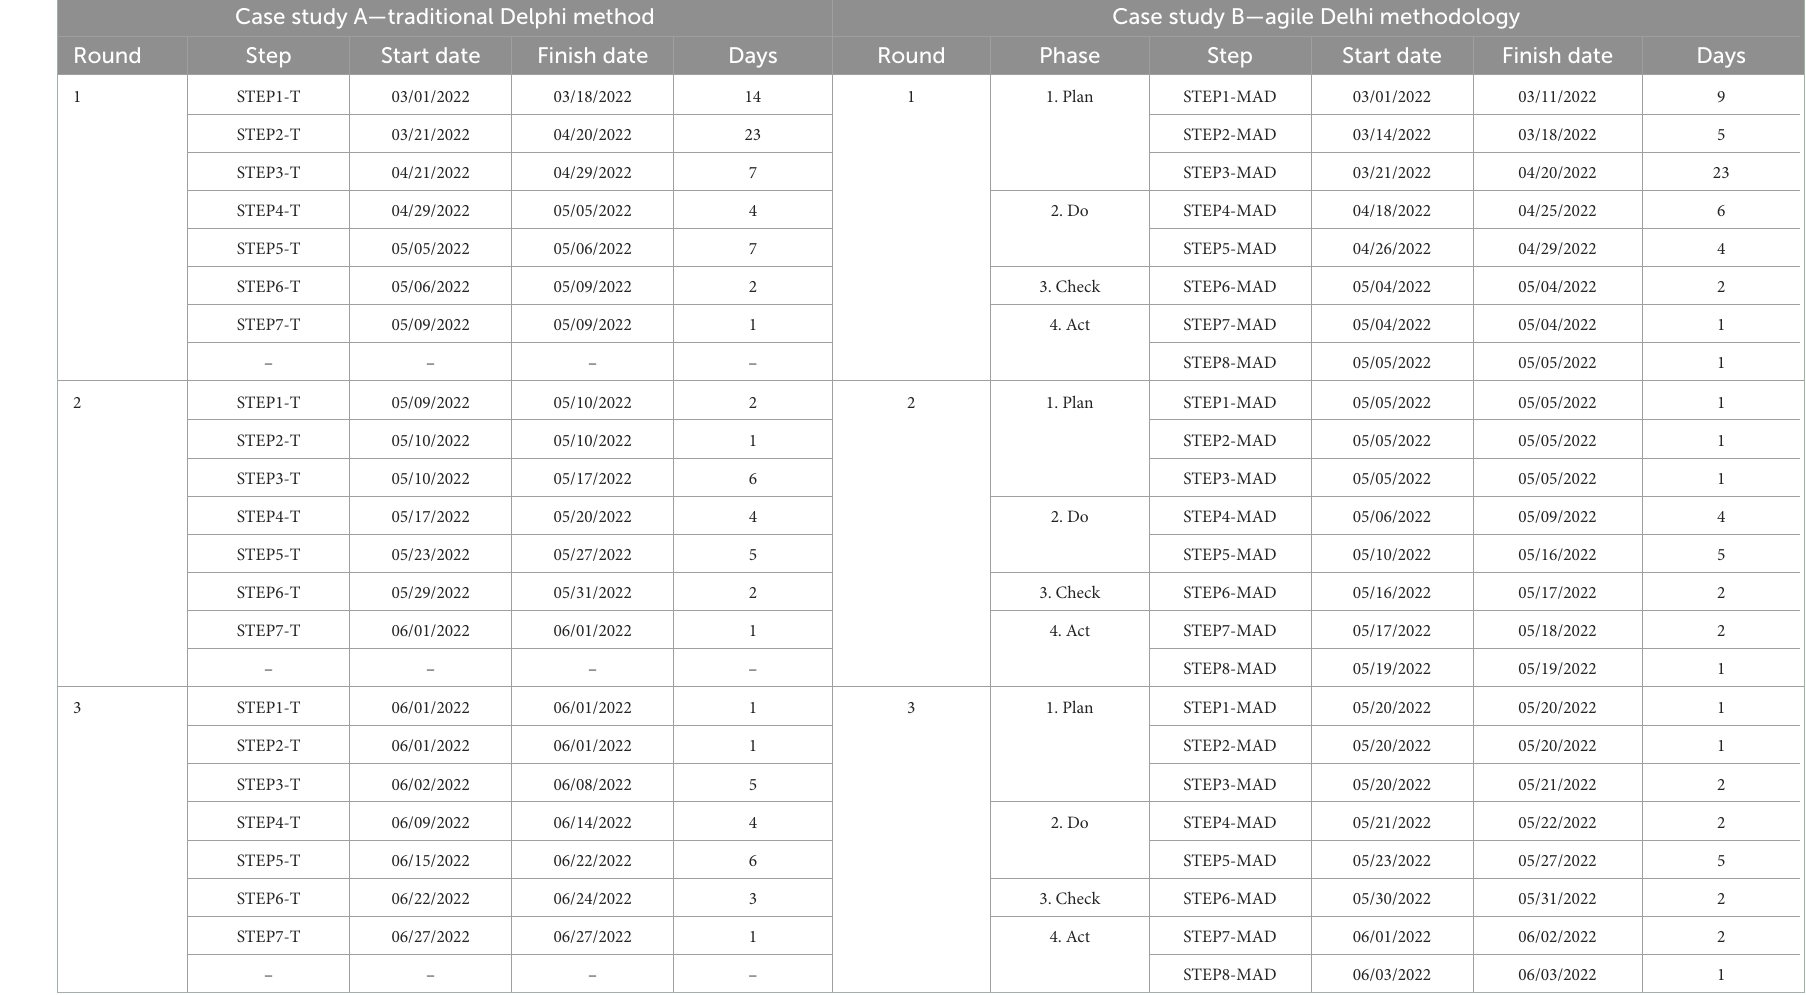
TABLE 10 CS-B: agile Delphi